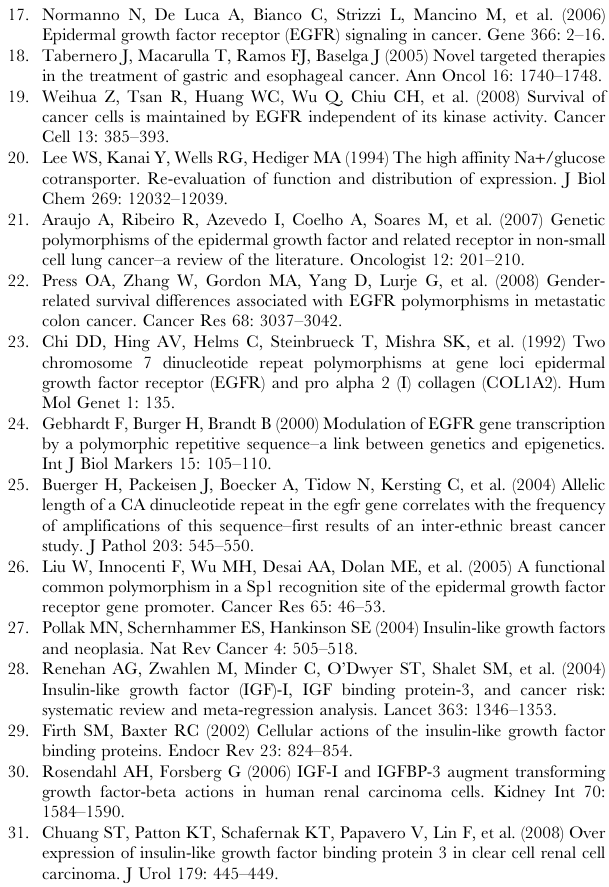
Figure S1 Sliding window results and linkage disequilibrium plot of CASP1/5/4/12 region. SNPs associated or located within a CASP gene are indicated by their respective lines. The haplotype results reported in Table 3 are indicated by a line depicting Region1. Upper portion of figure presents global p-value associated with each 3 SNP sliding window, unadjusted and FDR-adjusted. Lower portion of figure presents linkage disequi- librium plot with color scheme based on D’ and logarithm of the odds of linkage (LOD) scores. Numbers in the squares are r2 values. Figure S2 Sliding window results and linkage disequilibrium plot of EGFR region. The haplotype results for EGFR reported in Table 3 are indicated by lines depicting each region. Upper portion of figure presents global p-value associated with each 3 SNP sliding window, unadjusted and FDR-adjusted. Lower portion of figure presents linkage disequilibrium plot with color scheme based on D’ and logarithm of the odds of linkage (LOD) scores. Numbers in the squares are r2 values.